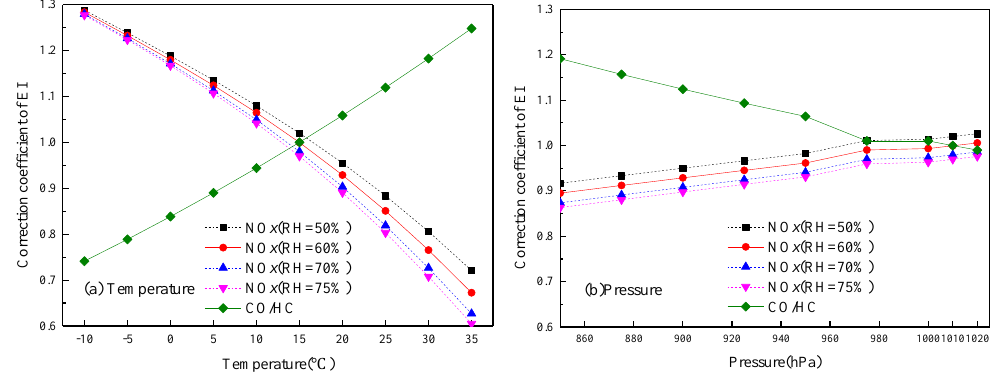
Figure 2. Correction coefficient of ЕІ (CCEI) vs. ( a ) ambient temperature ( b ) and pressure.